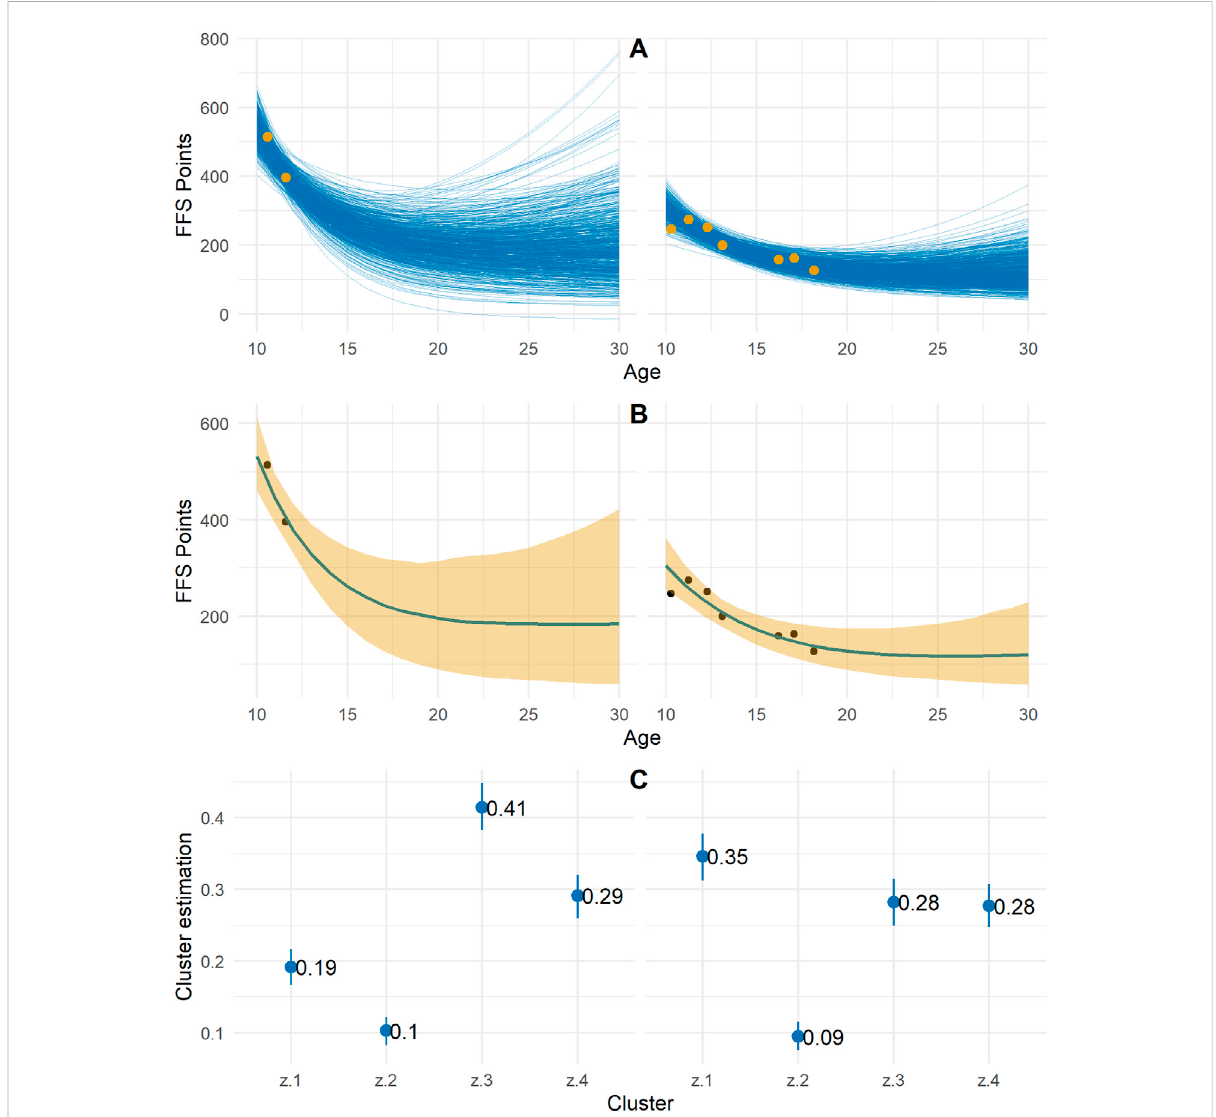
FIGURE 3 Example of two individuals (in column) of the estimate of the set of raw Moore curves (A) , of the median in blue and of the quantiles of order 0.025 and 0.975 in yellow (B) and of the mean and con fi dence interval of the probability of belonging to each of the clusters (C) . The yellow (A) and black (B) dots represent the actual performance